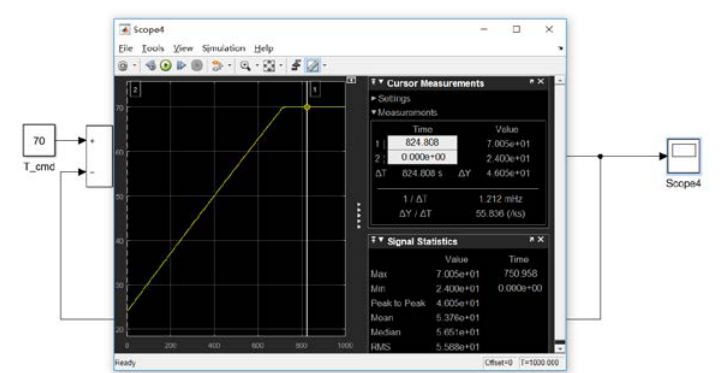
Fig. 7. Debugging result of water temperature 45 C ° .